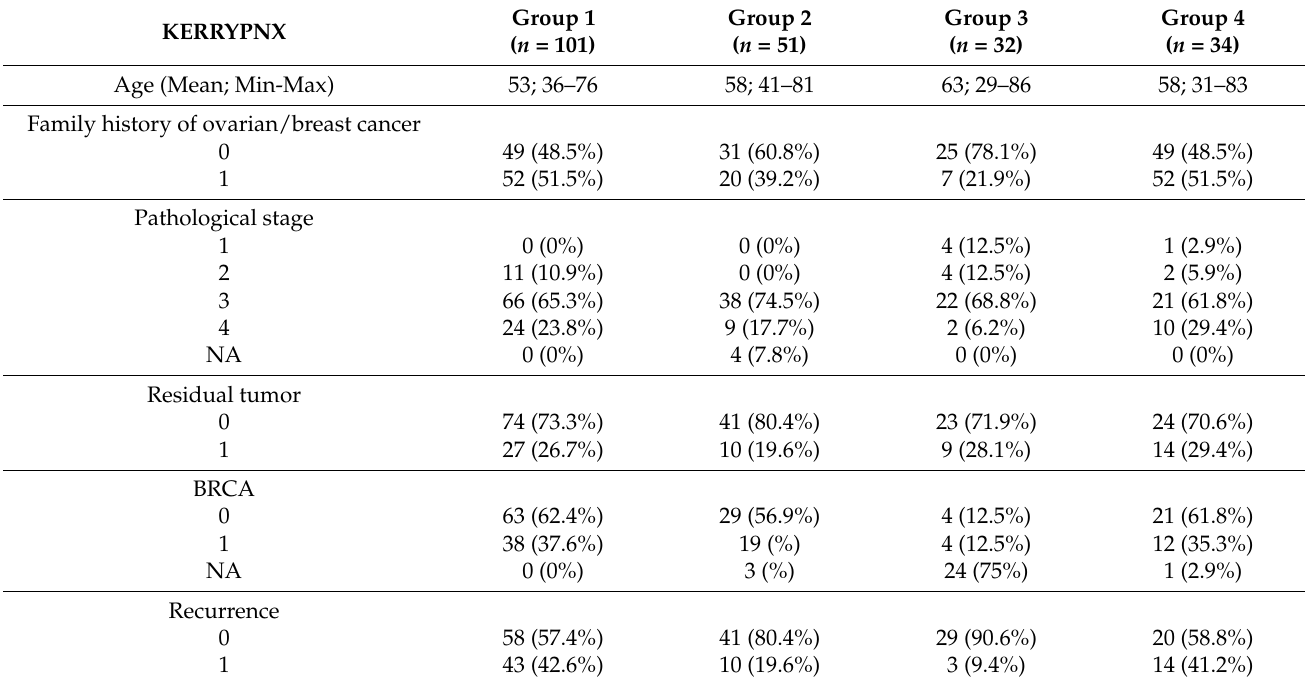
Table 1. Clinical information of included